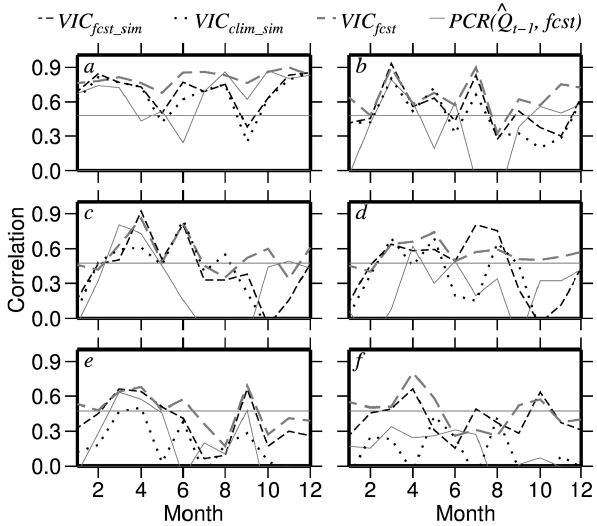
Fig. 6. Similar to Fig. 4, but the skill evaluated only for ENSO con-